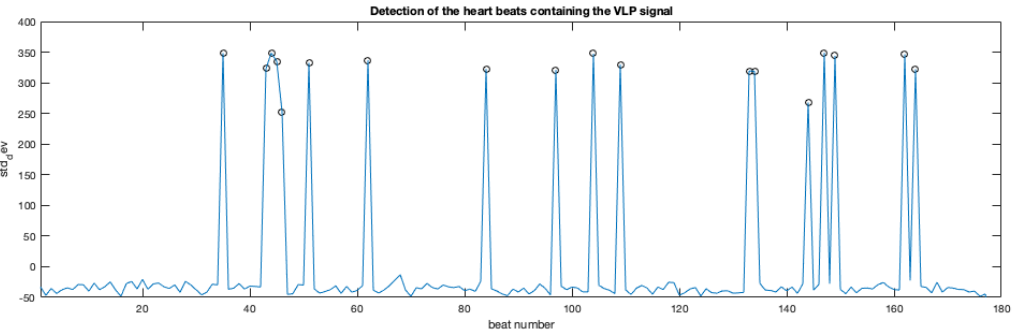
Figure 8. An example of VLP detection adopting the proposed beat-to-beat method in presence of VLP peak amplitude 40 dB below the R